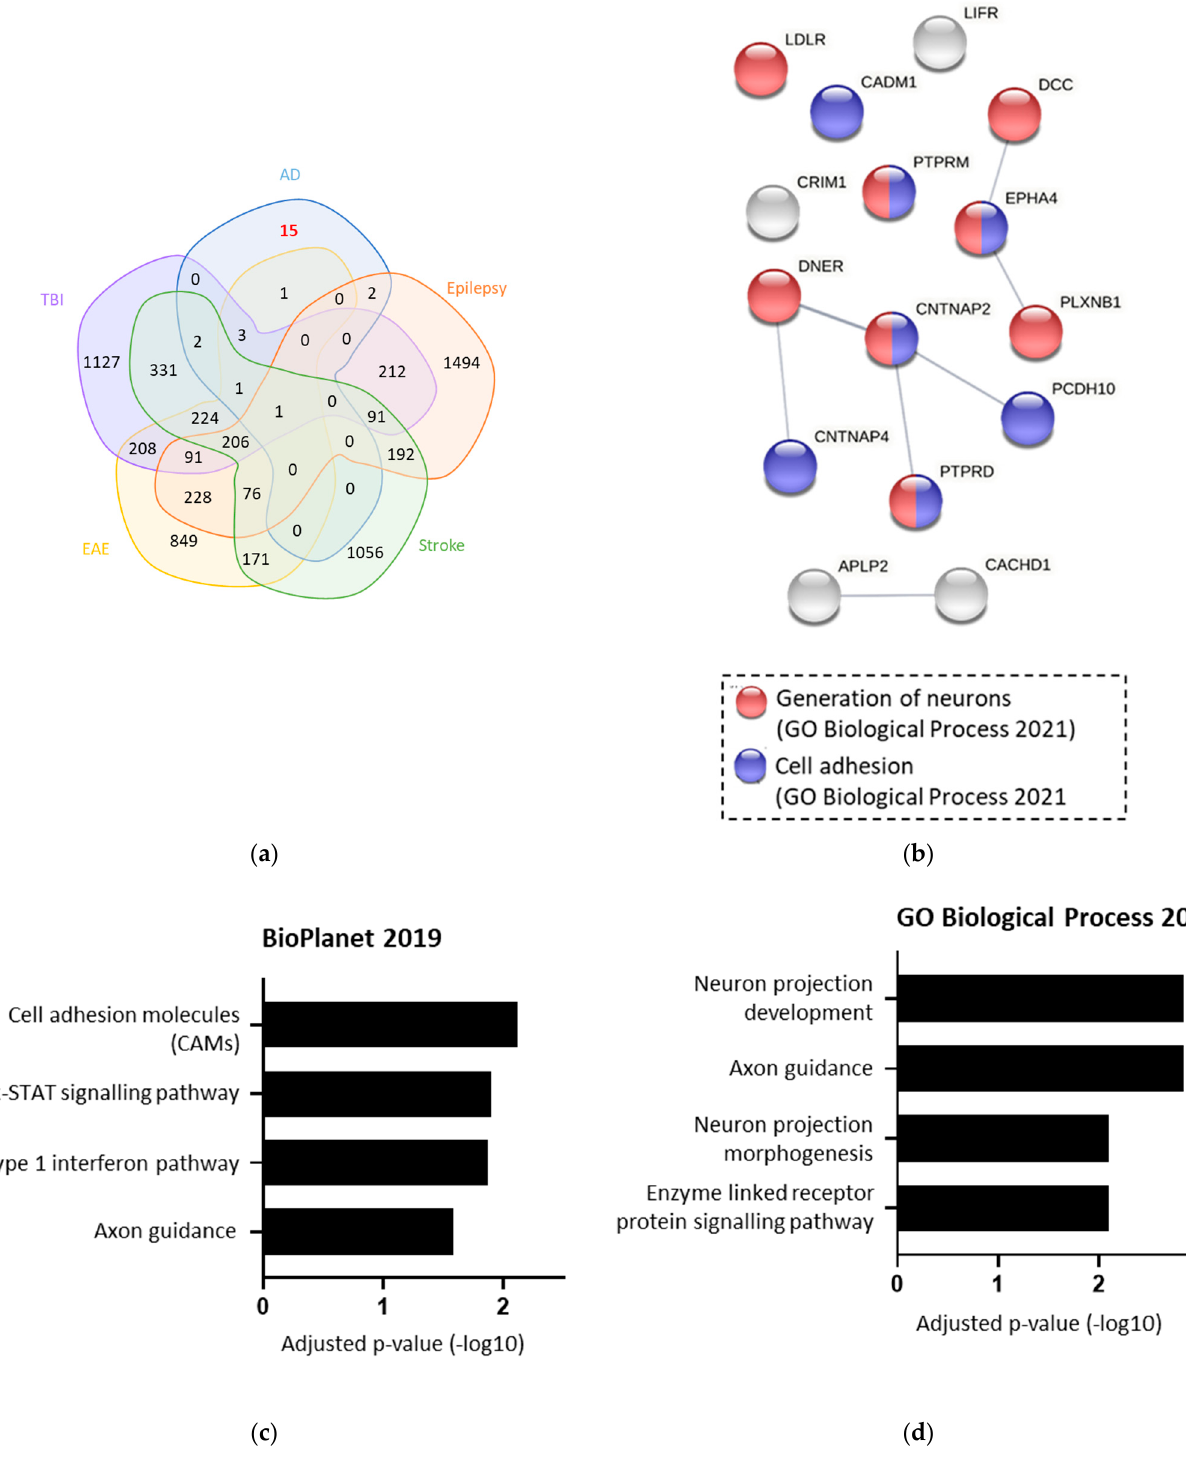
Figure 5. The 15 BACE1 substrates were Alzheimer’s disease (AD)-specific when compared against other diseases. ( a ) Venn diagram overlaying 25 BACE1 substrates differentially expressed (DE) in AD with proteins DE in traumatic brain injury (TBI), epilepsy, stroke, and experimental autoimmune encephalitis (EAE) (50)). ( b , c ) Terms from various databases when the 15 AD-specific BACE1 substrates were input into Enrichr, showing log of adjusted p -value. ( d ) String analysis of the 15 AD-specific BACE1 substrates, showing associations with GO terms.